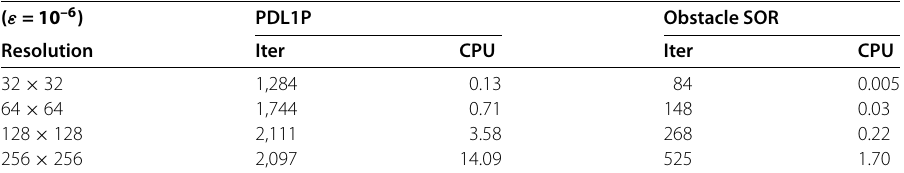
ForPDL1P[14],set μ =10 8 , r 1 =0.01 ,and r 2 =12.5